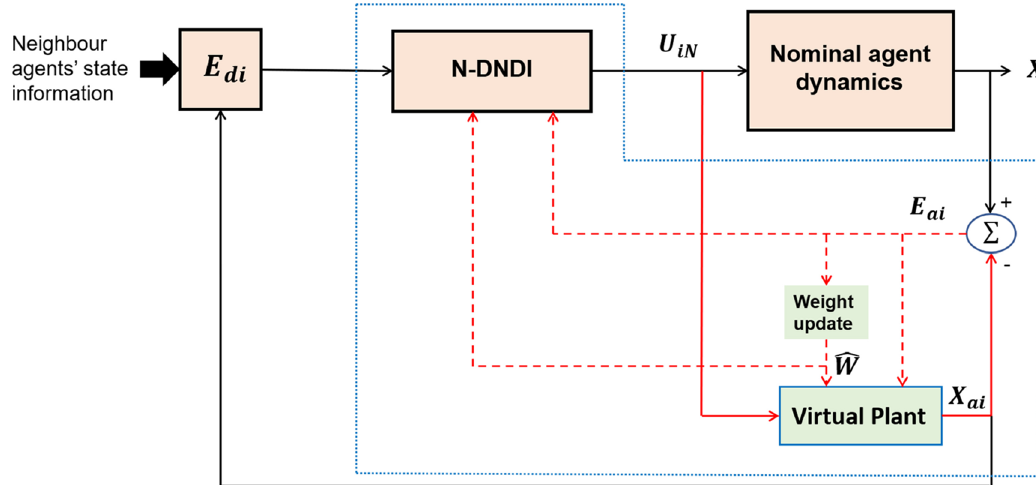
Figure 3. Block diagram of Neuro-adaptive DNDI or